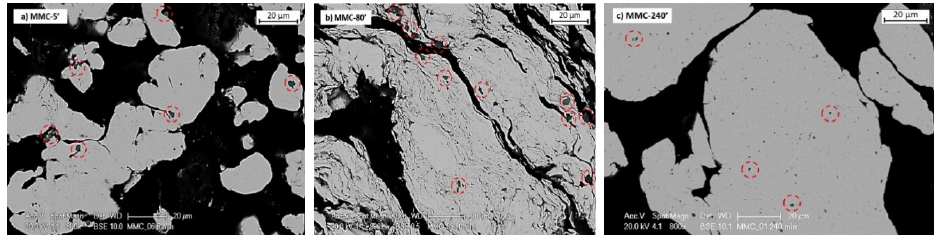
Figure 4. SEM micrographs of powder cross section of ( a ) MMC ‐ 5 ′ , ( b ) MMC ‐ 80 ′ and ( c ) MMC ‐ 240 ′ .